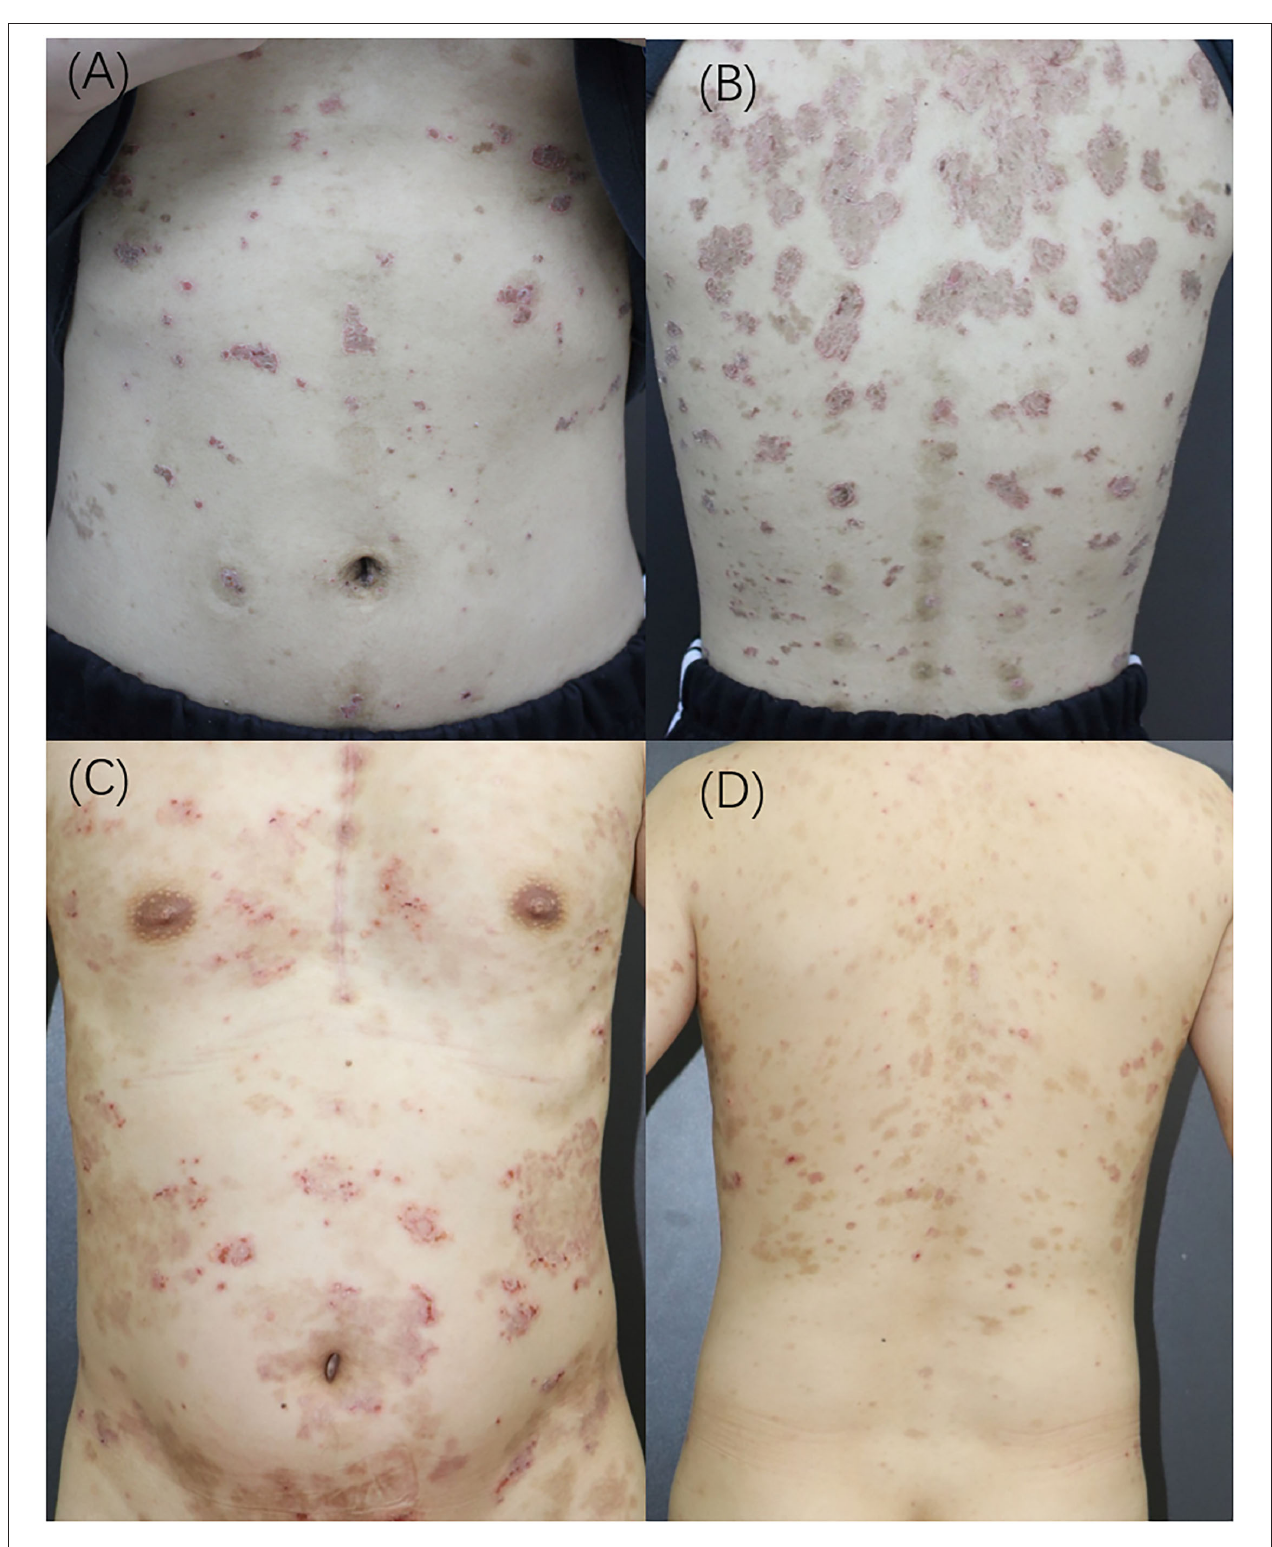
FIGURE 1 | (A,B) Clinical presentations of Case 1; (C,D) Clinical presentations of Case 2.